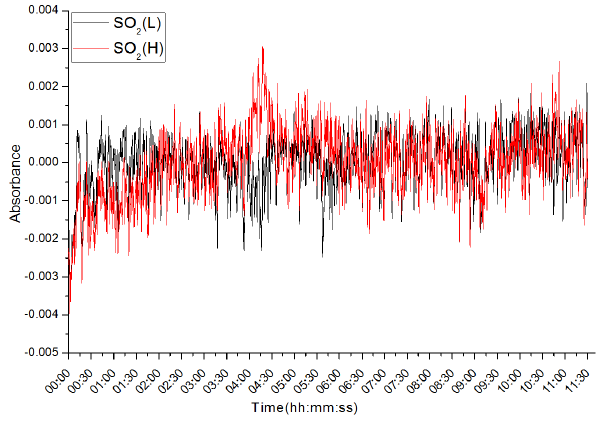
Figure 6. Absorbance time series for the SO 2 (L) and SO 2 (H) chan- nel under a zero gas (99.999% N 2 ) condition. Sample data more than 10h are